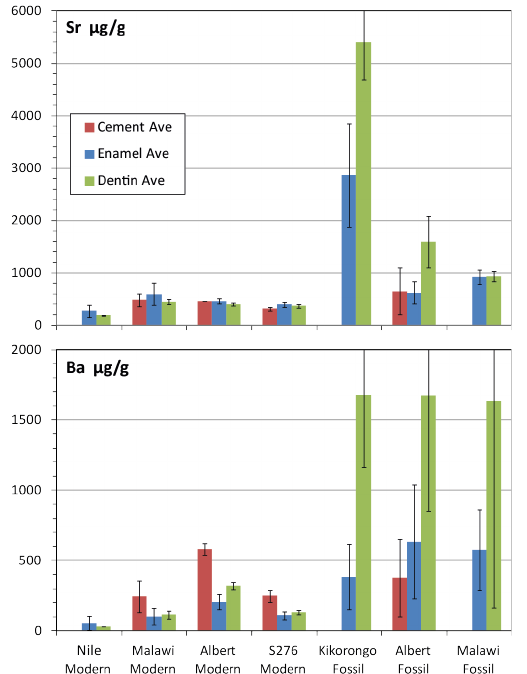
Fig. 1. Average Ba and Sr concentrations in cement, enamel and dentin of modern and fossil hippopotamid teeth. Error bars repre- sent the 1 σ error of the average.